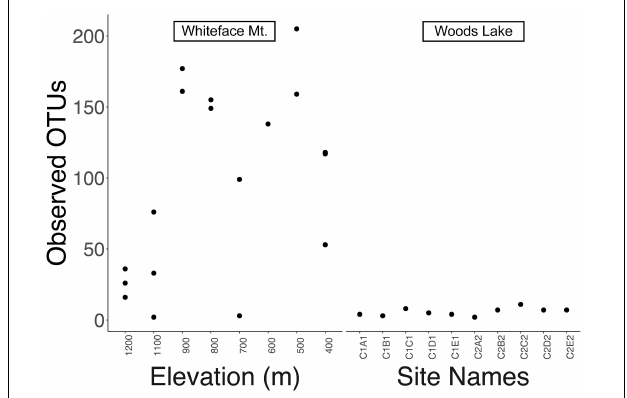
FIGURE 2 | Alpha diversity is represented as number of observed OTUs in each sample. Streptomyces at Whiteface Mountain ( left ) exhibited maximal richness at mid elevations with decreasing alpha diversity at the highest and lowest sites. Streptomyces at Woods Lake (WL; right ) exhibited little change in alpha diversity with respect to elevation change. Sample names are provided instead of elevations in the right panel because elevation does not vary across the WL watershed (largest elevation difference is 33 m, Table 1